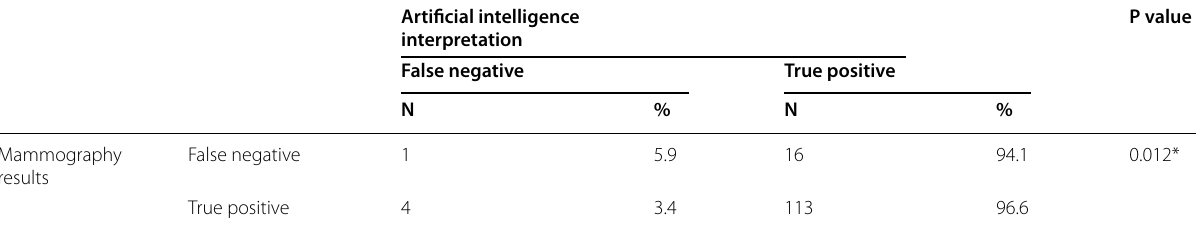
* McNamara test Table 3 Comparison between results of mammography and AI system